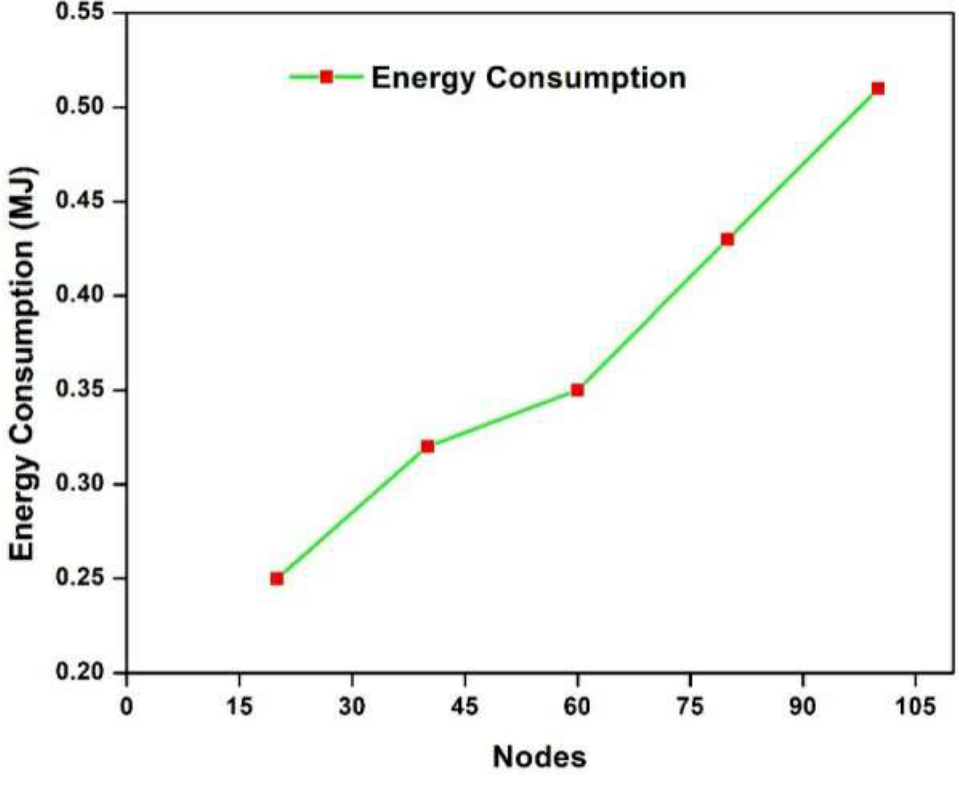
Figure 8. Energy consumption of proposed method.